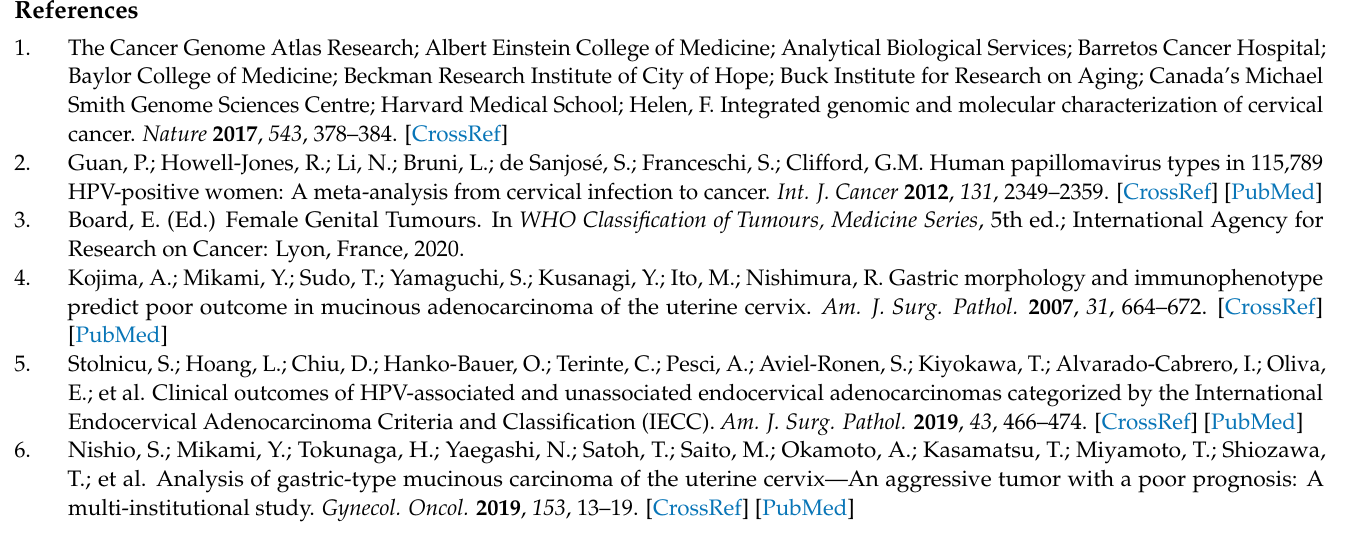
p16 status; Figure S2: Survival outcomes of patients with IIB disease who underwent surgery; Table S1: Logistic regression and multiple regression analysis to identify significant clinico-pathological fac- tors that differentiate HPVa and HPVi type; Table S2: Chemotherapeutic regimen used for treat- ment; Table S3: Detailed pathological information and results of immunohistochemistry staining; Table S4: Cases with HPVi (GAS) treated with definitive radiotherapy with or without concurrent